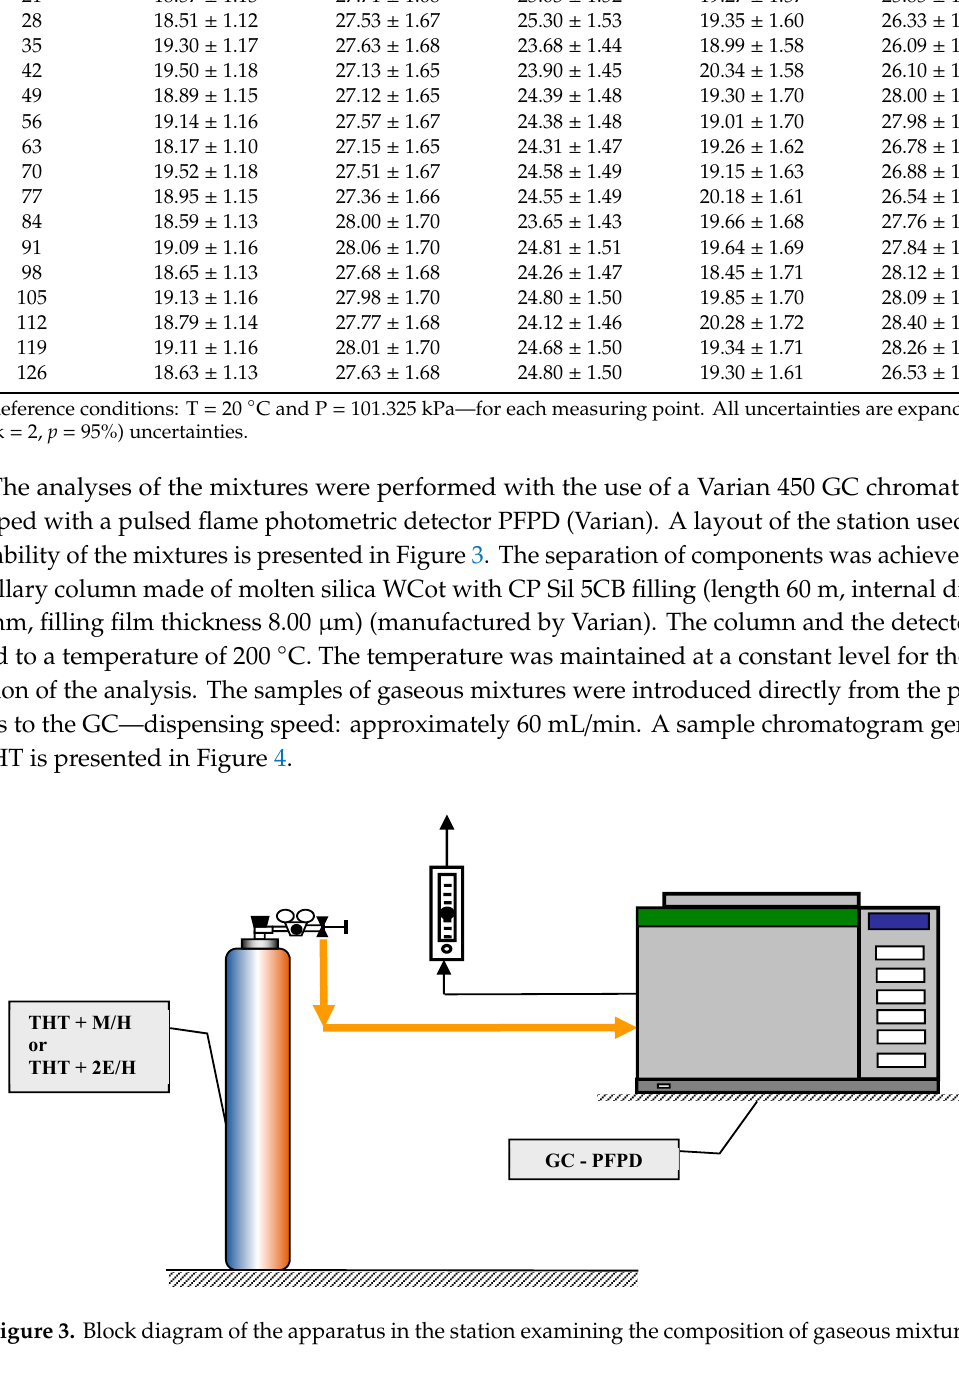
Figure 4. Sample chromatogram generated for a mixture of THT in M/H15 with a THT concentration of 6.70 ppm ( x THT = 24.60 ± 0.50 mg/m 3 , T = 20 ° C and P = 101.325 kPa). 3. Results The results of testing the stability of THT concentration in the mixtures (as well as the stability of their odorization) with the compositions specified in Table 2 are presented in Table 3, and graphically in Figures 5 and 6. Each time, the values of expanded uncertainty (for k = 2, p = 95%; presented as error bars on graphs) were specified along with the values of concentration. The value of THT concentration for a timeframe of 0 days ( x 0,THT ), determined once the composition of the mixture had stabilized, was considered to be the reference value (interchangeably: the attributed value). For each of the reference values, the THT concentration was expressed as mass concentration ((mg/m 3 ) in the contents of the table for the point of 0 days) and a molar fraction (ppm (mol/mol) in the header of the table), in both cases with a proper attributed value of uncertainty.